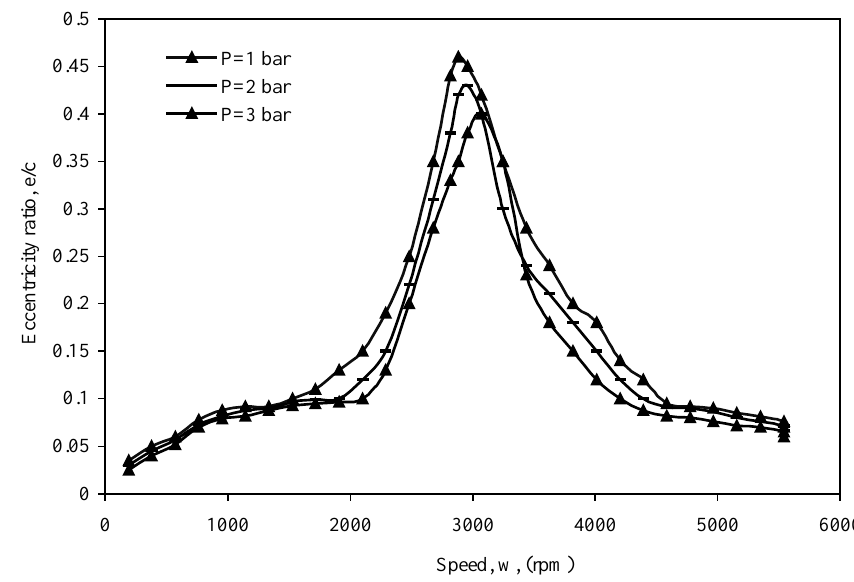
Fig. 7. Speed – eccentricity ratio relation for steel squeeze film damper (L/d = 0.93, c = 0.9).